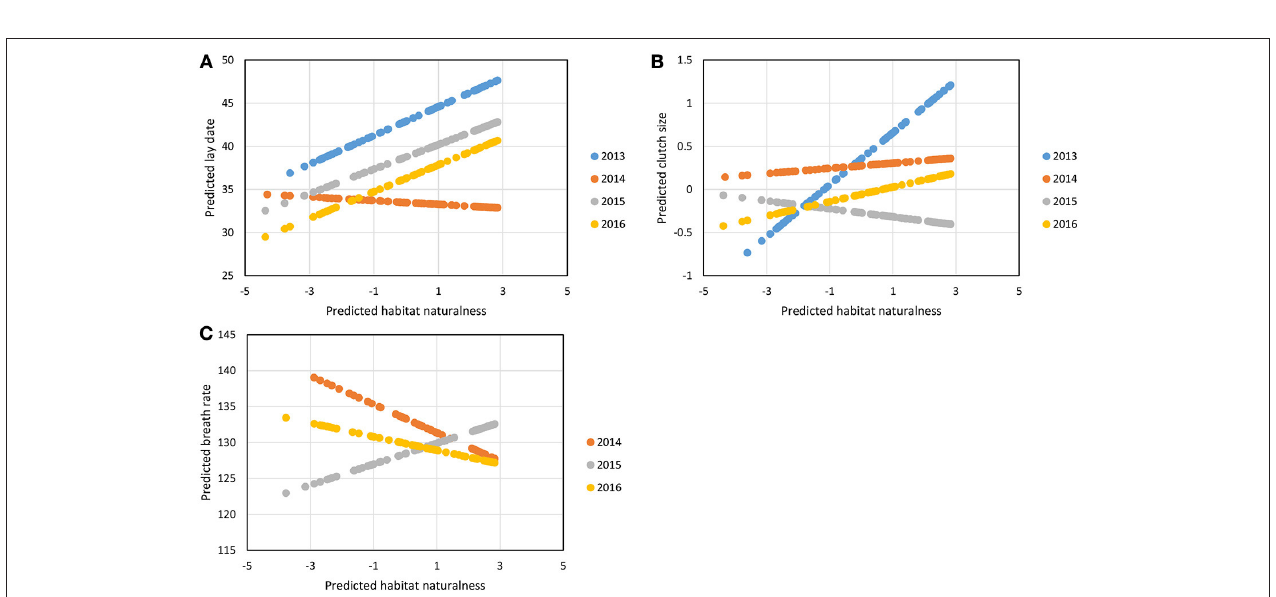
FIGURE 2 | Predicted contrasts in breeding [ A , lay date; B , clutch size; C , number of hatchlings (from a model controlling for clutch size), D , number of fledglings (controlling for number of hatchlings)], behavior ( E , handling aggression; F , exploration score) and physiological traits ( G , breath rate) between great tits from the forest of La Rouvière and great tits from the city of Montpellier. The graphs present the boxplot of predicted values from models detailed in Table 3 . For lay date, 1 = 1st March. Breath rate is in number of breaths/min.